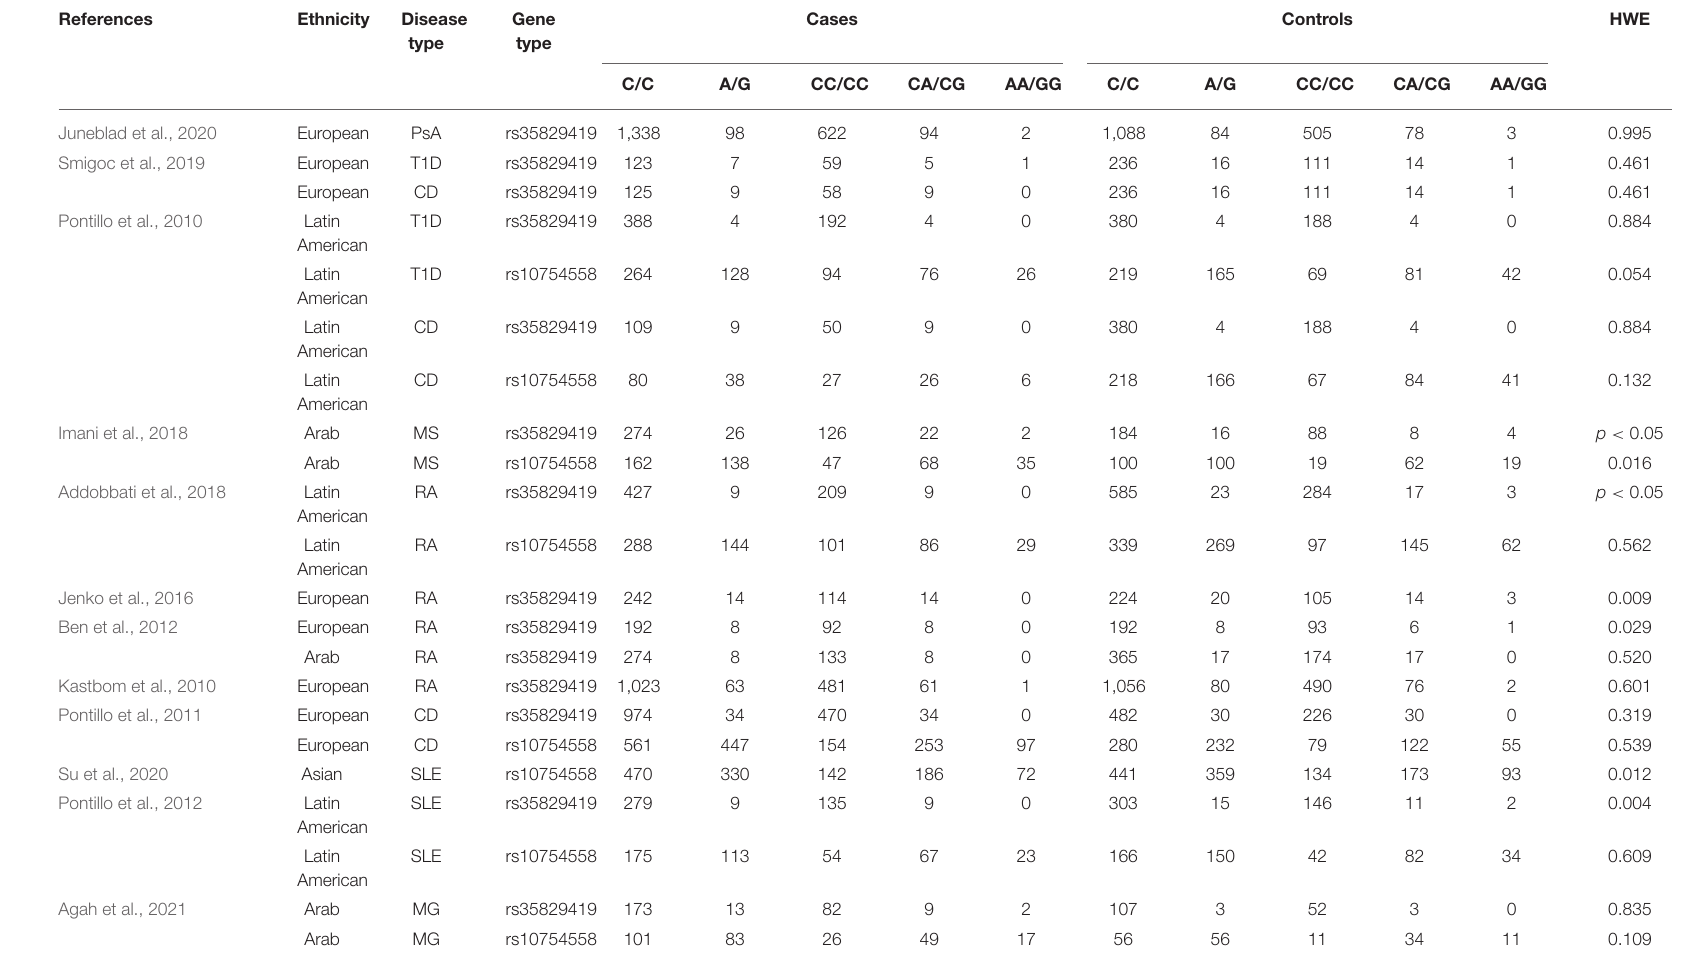
TABLE 2 | Data of allele and genotype frequencies in all included